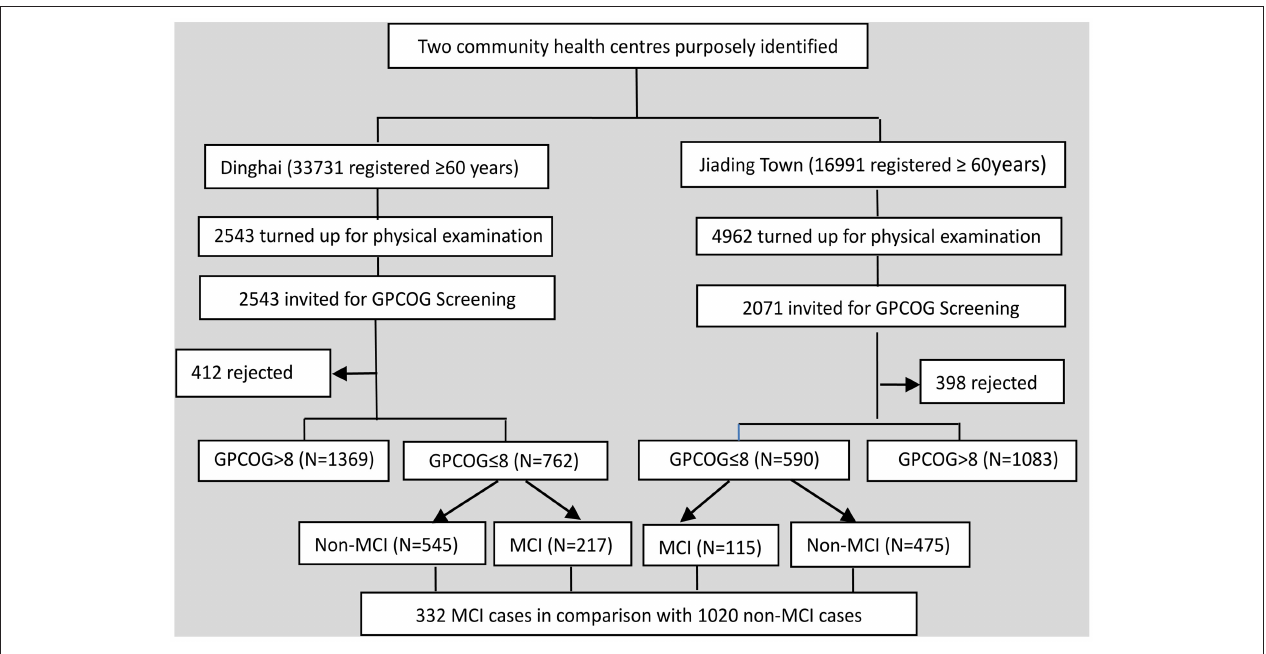
FIGURE 1 | Study flow diagram. GPCOG, General Practitioner Assessment of Cognition-Chinese version; MCI, mild cognitive